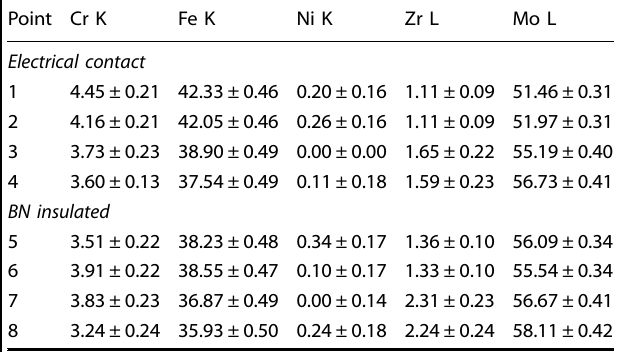
Points correspond to those labeled in Fig. 4. Data generated by Path fi nder EDS software v.2.4 and reported units are in